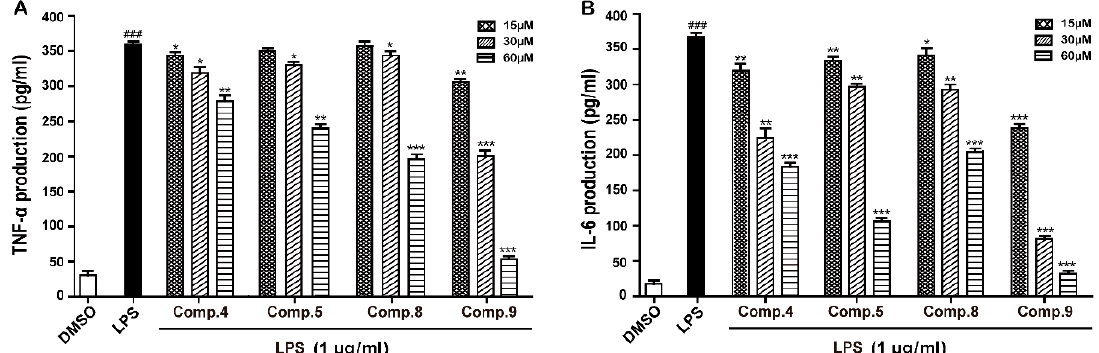
Figure 6. Inhibition of compounds 4 , 5 , 8 , and 9 on TNF- α and IL-6 production in LPS-induced RAW 264.7 cells. The cells were pretreated with various concentrations (0–60 µ M) of 4 , 5 , 8 and 9 for 2 h and then incubated with or without LPS (1 µ g/mL) for 24 h. Extracellular production of TNF- α ( A ) and IL-6 ( B ) in culture media were measured using commercial ELISA kits. The data show mean ± SD values. ### , p < 0.001 was compared to control. *, p < 0.05, **, p < 0.01, ***, p < 0.001 were versus LPS.